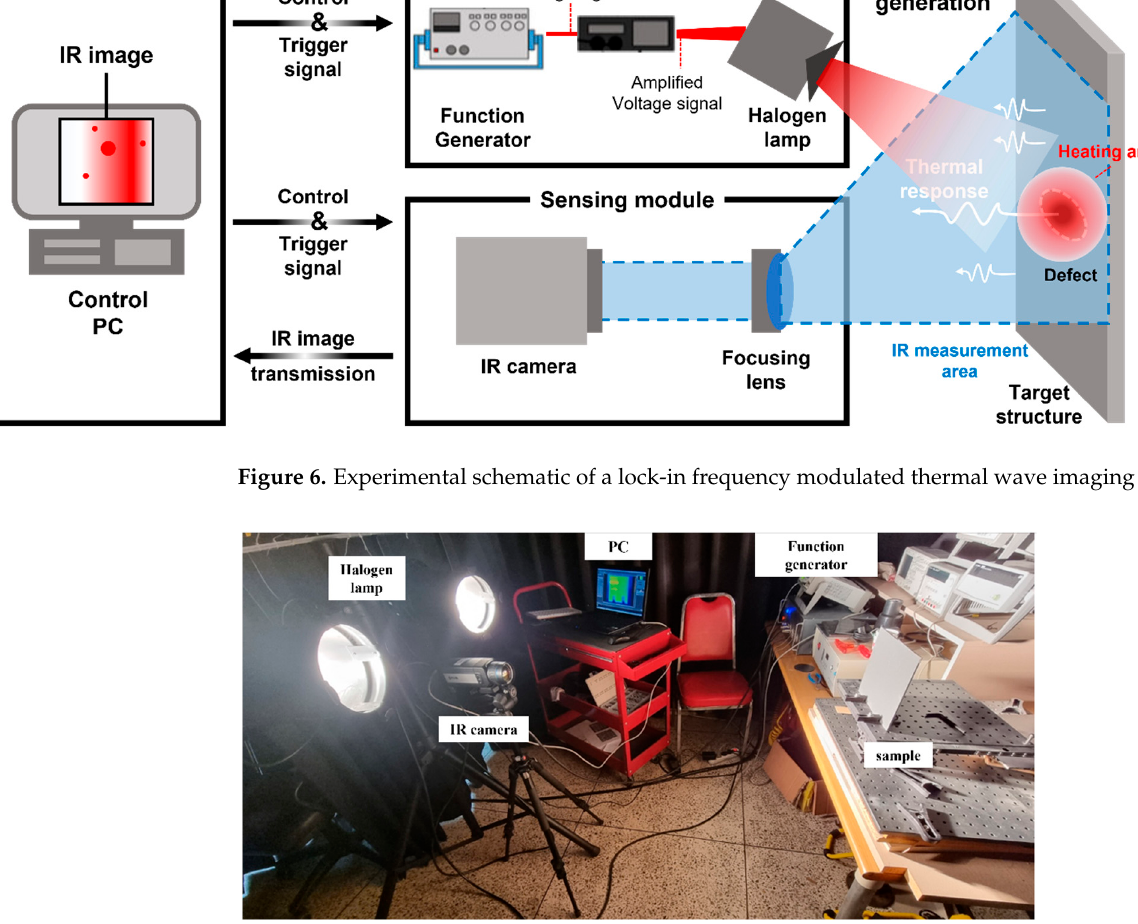
Figure 7. Picture undergoing thermographic testing on the sample.